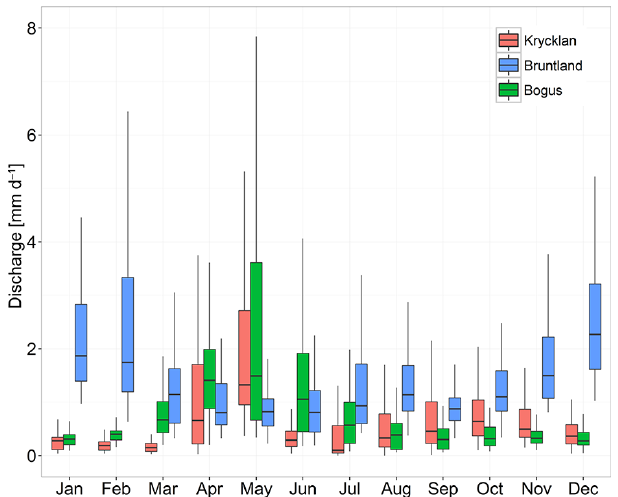
Figure 3. Isotope samples of streamflow for each site grouped into monthly bins where the jitter plots show all data points and box plots summarize the span of the data. For Bogus we show data presented by Kormos (2005) which were not used in model calibration due to problems with the flow